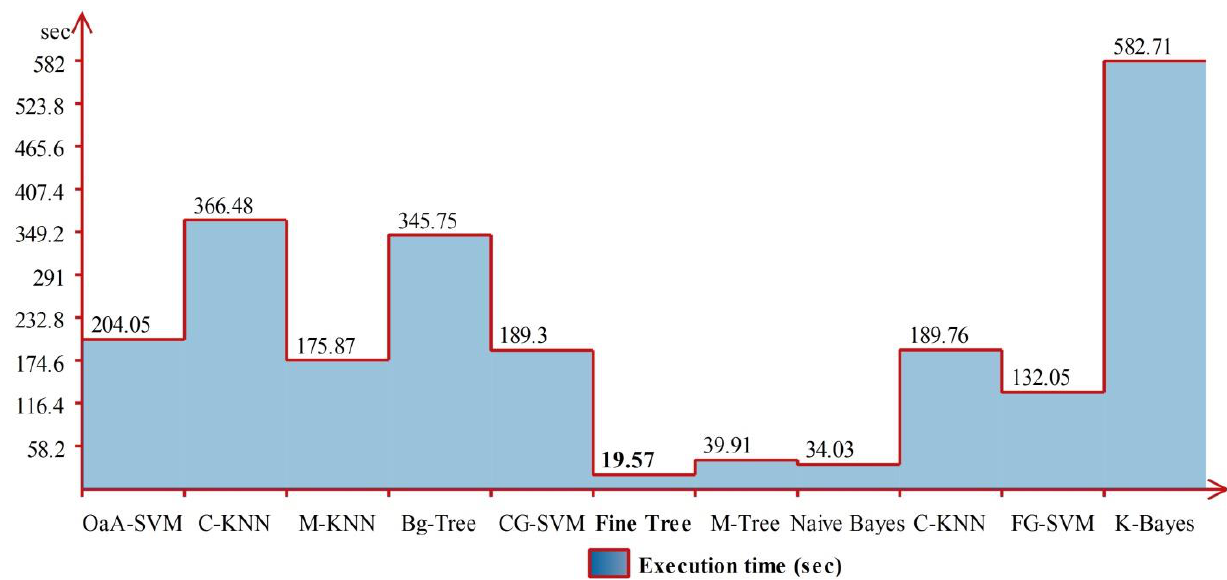
Figure 9. Variation in computational time for selected classifiers on Real time dataset.